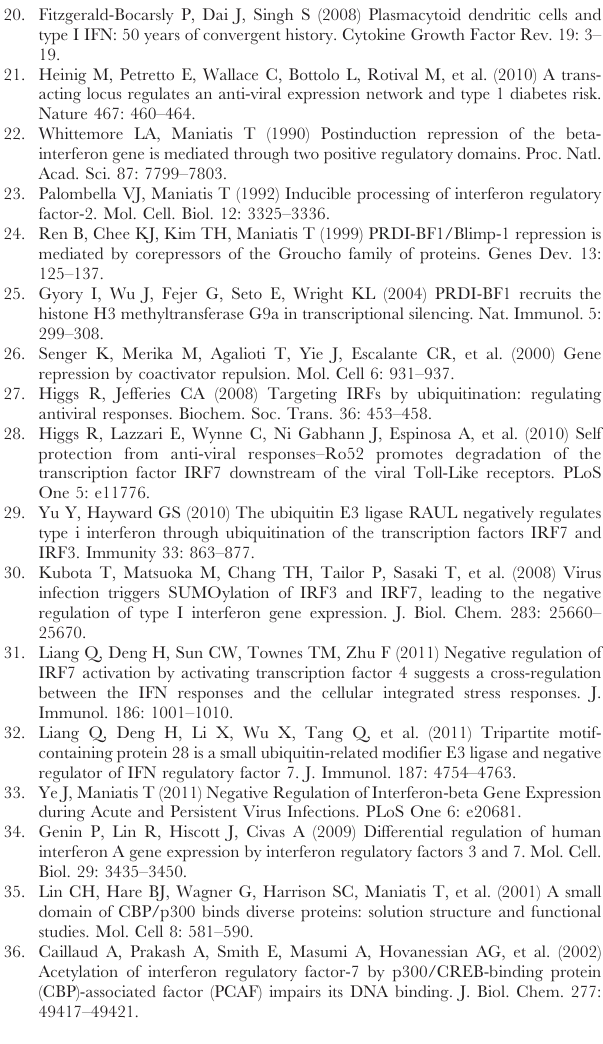
Figure S2 Virus-induced histone H3 acetylation pattern associated to IFN-A gene promoters. ( A ) H3K9 and H3K14 acetylation levels associated to IFN-A1, A7 and A14 gene promoters and to their coding regions were determined by ChIP-QPCR in Namalwa B cells infected by Sendai virus, as described in Figure 3A . ( B ) Recruitment of GCN5 and PCAF to the IFN-A1 and A14 promoters was determined by quantitative ChIP assays in Namalwa B cells infected by Sendai virus as described in Figure 3B . Figure S3 Negative controls of ChIP-QPCR experi- ments. ( A ) Constitutive H3K9 and H3K14 acetylation levels associated to IFN-A1, A2, A7 and A14 gene promoters were determined by ChIP-QPCR in Namalwa B cells at different time points, as described in Figure 3A . ( B ) ChIP-QPCR experiments carried out with chromatin extracts in the absence of antibodies or in the presence of actin antibodies using primers for IFN-A1, A2, A7 and A14 gene promoters were performed in Namalwa B cells infected by Sendai virus, as described in Figure 3A . Figure S4 Effect of HDAC overexpression on IRF7- mediated IFN-A gene transcription. The effect of